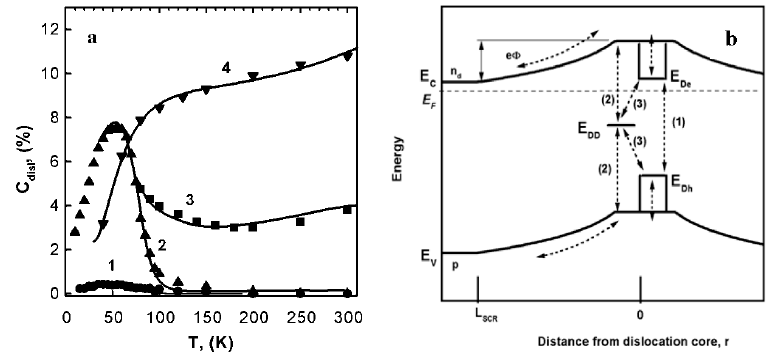
Figure 19. ( a ) Temperature dependencies of EBIC contrast C disl (T) of dislocations in Si. Points are experimental data [98], solid curves are calculated using the model [104]. ( b ) Charge carrier recombination at dislocations. For clean dislocations the recombination rate is determined by direct by the paths (3) via this deep level [104].